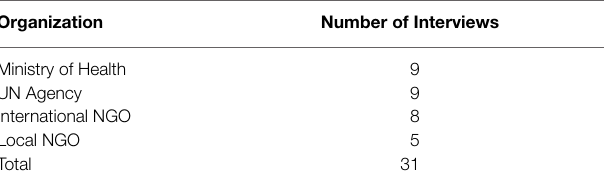
TABLE 1 | Number of interviews with key informants, by organization